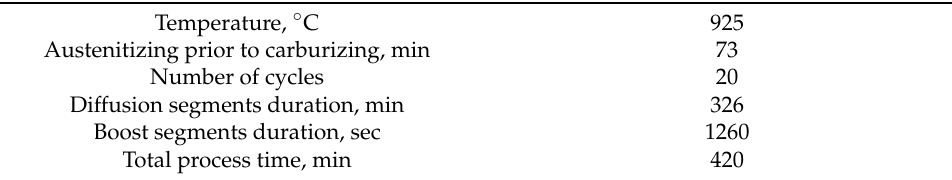
Table 2. Low-pressure carburizing multi-segment process parameters.